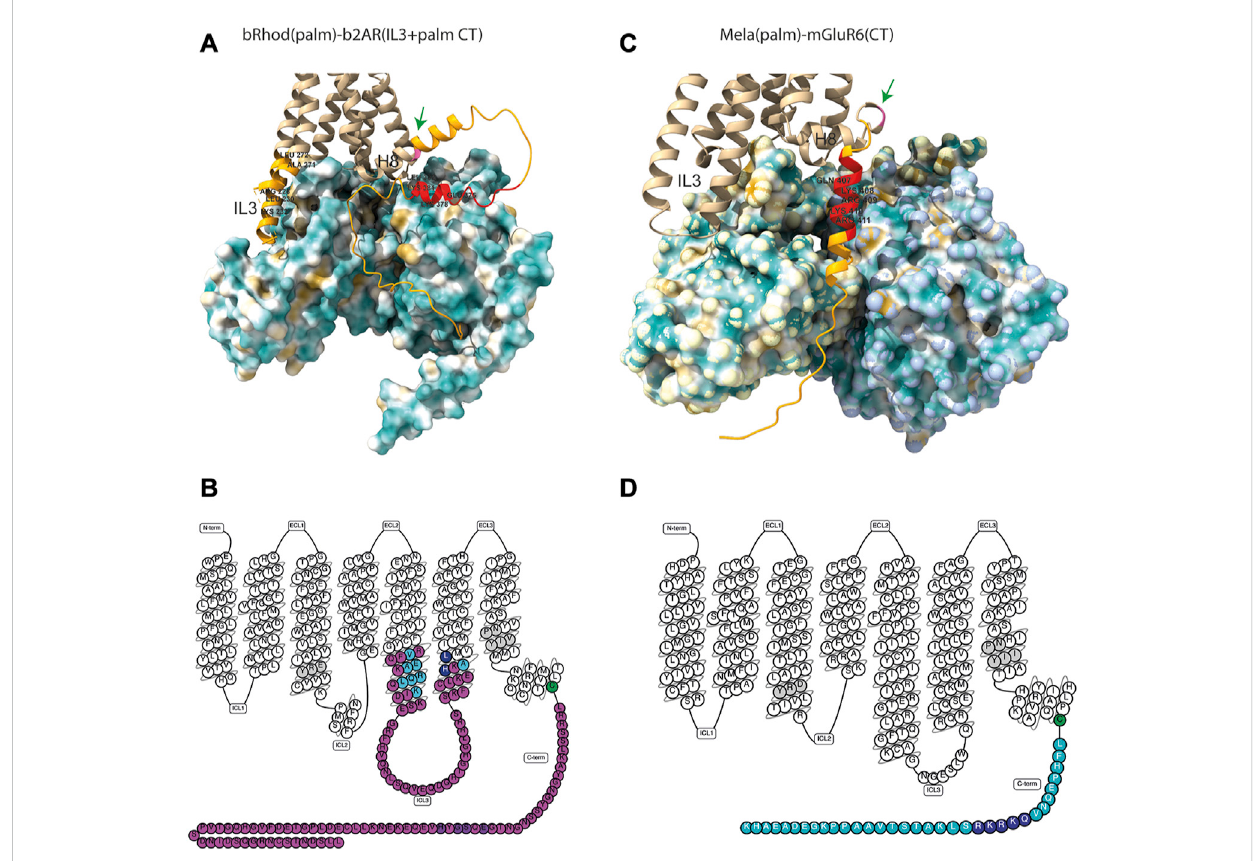
FIGURE 5 Structures of the bRhod(palm)-b2AR(IL3+CT) and Mela(palm)-mGluR6(CT) chimeras. (A,B) AlphaFold-predicted structural models of the chimeras with hydrophobicity surface maps of their respective G-proteins. (A) Structural model of the bRhod(palm)-b2AR(IL3+CT) chimera with the Gs-alpha and Gbetasubunits.Highlightedinlightorangearetheb2ARdomains.Theresidueshighlighted additionally inredaretheanalogues totheresiduesthatform contacts with the Gbeta subunit in rhodopsin (Tsai et al., 2019). The palmitoylation site is indicated in pink (green arrow). (B) Structural model of the Mela(palm)-mGluR6(CT) construct with the Gi-alpha and Gbeta subunits. Highlighted in orange is the C-terminal domain of mGluR6. The residues highlightedinadditioninredareanalogoustotheresiduesinmGluR2thathavebeenshowntoformcontactswiththeGalphasubunit(Sevenetal.,2021). (C,D) Snakeplots of the chimeras. (C) Snakeplot of the bRhod(palm)-b2AR(IL3+palm CT) construct. Shown in pink are the b2AR domains, which were inserted in bRhod. The residues that form contacts with the G-protein [light blue (Rasmussen et al., 2011b) and dark blue (Zhou et al., 2019)] are highlighted,aswellastheresiduesthatareanalogoustotheresiduesthatformcontactswiththeGbetasubunitinrhodopsin[purple(Tsaietal.,2019)]. (D) Snakeplot of Mela(palm)-mGluR6(CT). Shown in light blue is the C-terminus of mGluR6, which was added following H8 and the palmitoylation site (green).TheresiduesthatareanalogoustotheresiduesthatformcontactswiththeG-proteininmGluR2[darkblue(Sevenetal.,2021)]arehighlighted.In grey are the highly conserved DRY and NPxxY